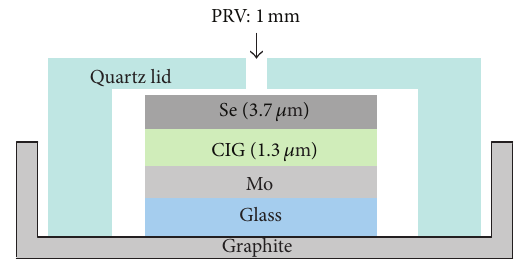
Figure 1: Schematic diagram of the selenization equipment with the pressure release valve design.